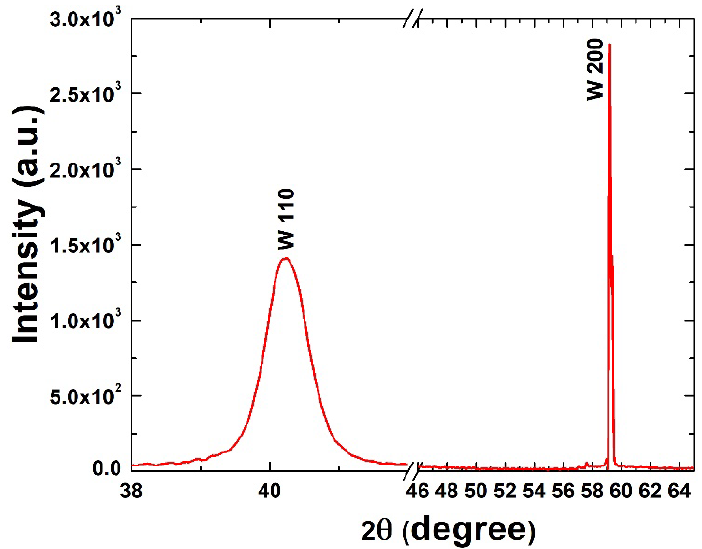
Figure 3. XRD diffraction pattern of 500 nm thick tungsten layer.